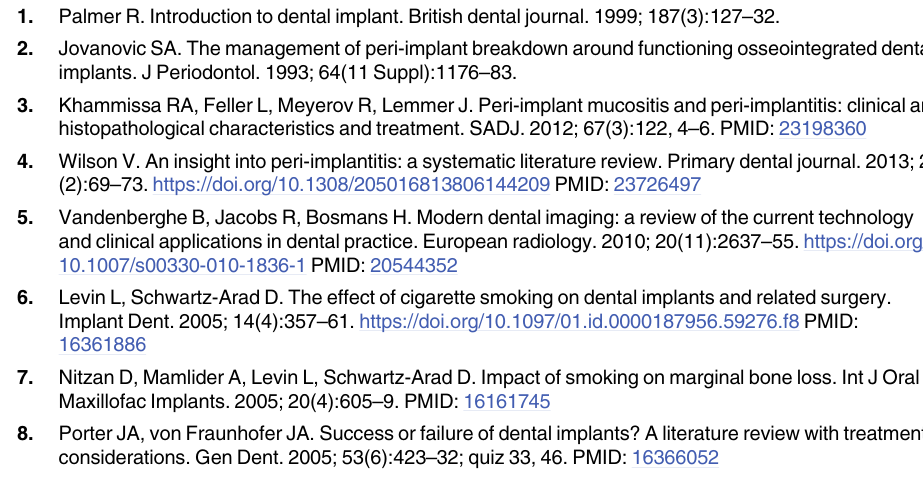
S2 Table. Listing of optical implant reference thread depth measurements (5 estimates per implant, with 3 repetitions each). True thread pitch (last column) was obtained from the manufacturer